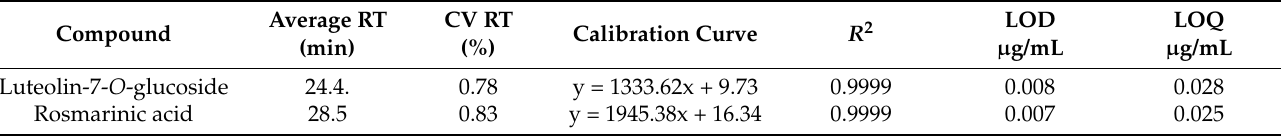
Table 1. Chromatographic parameters for HPLC method for determination of phenolic compounds in Satureja montana extracts.